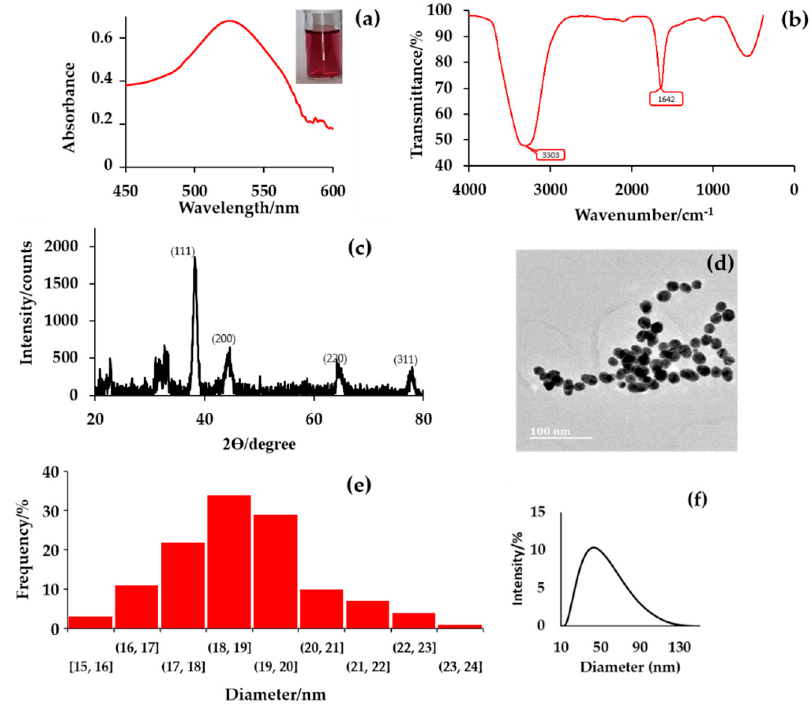
Figure 1. The characterization of citrate-capped AuNPs via, ( a ) UV–vis spectroscopy and colour modulation, ( b ) FT-IR spectroscopy, ( c ) XRD analysis, ( d ) TEM imaging, ( e ) particle size distribution obtained from several TEM images, and ( f ) zeta sizer size distribution.